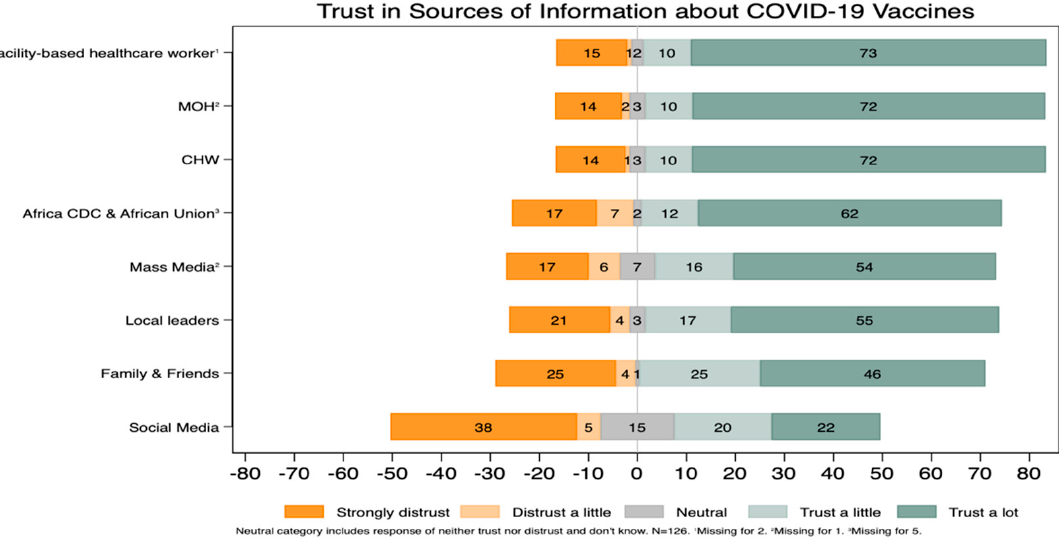
Figure 4. Trust in sources of information about COVID-19 by vaccine.